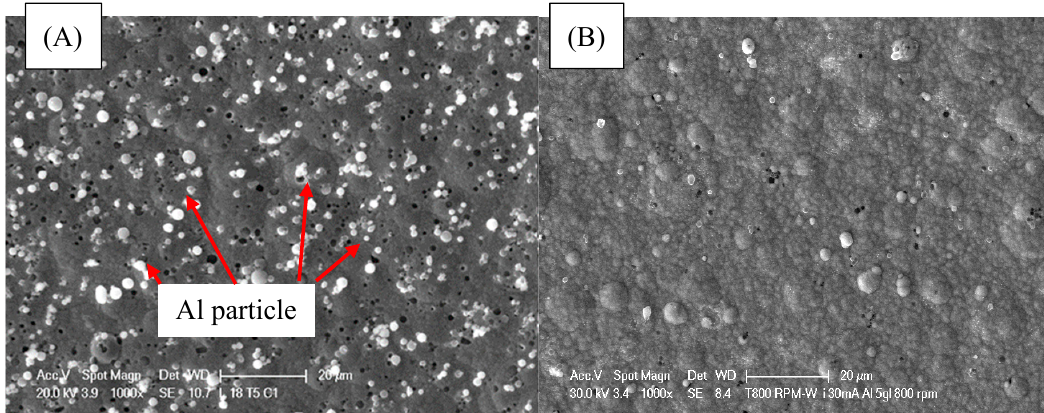
Figure 10. Surface morphology of coatings obtained at current density of 30 mA/cm 2 , temperature of 40 °C, Al content in the solution of 5 g/L, and different stirring rates: ( A ) 650, and ( B ) 800 rpm.